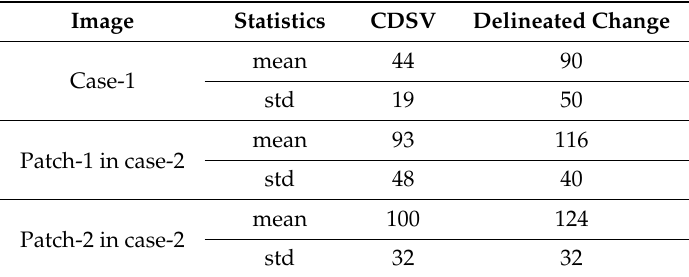
Table 5. The statistics of pixel values of the specific areas in the image of HECred_V of two cases. The specific areas were the delineated change areas and the omission areas of CDSV. Image